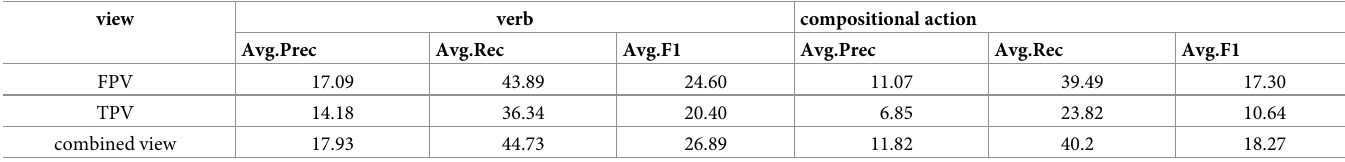
FPV indicates first-person view and TPV indicates third-person